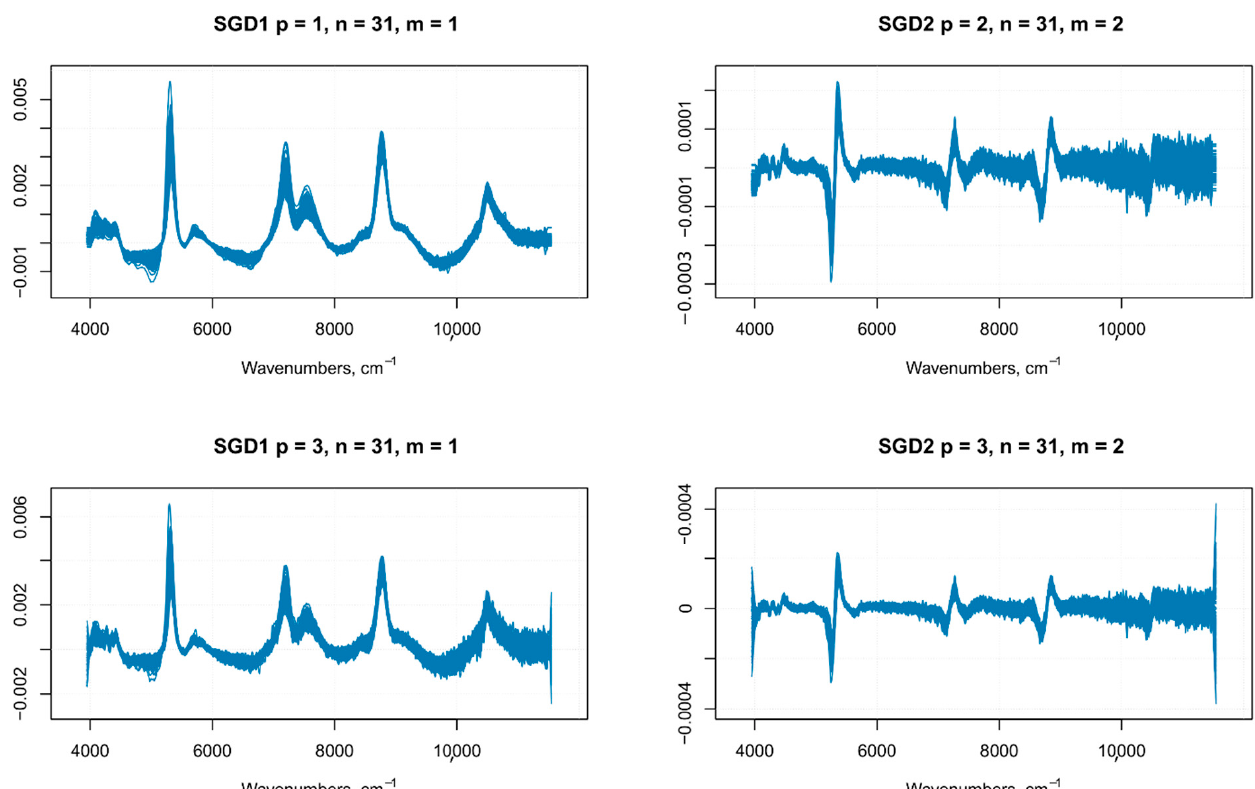
Figure 4. SGD1 and SGD2 with different polynomial order (p) and frame size (m).